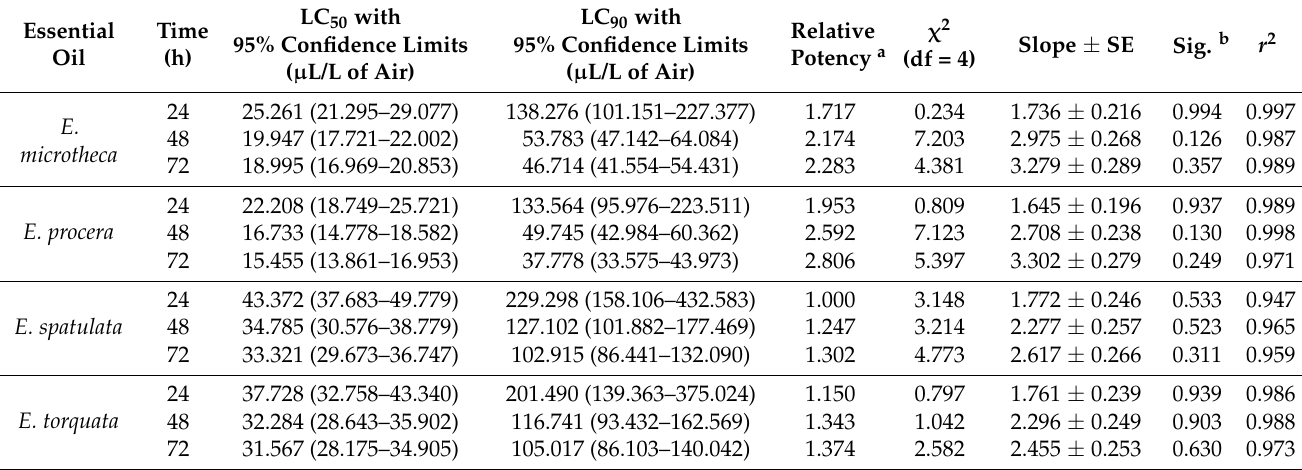
Table 3. Probit analyses of data obtained from the fumigant toxicity of Eucalyptus microtheca , E. procera , E. spatulata , and E. torquata essential oils against the adults of Rhyzopertha dominica